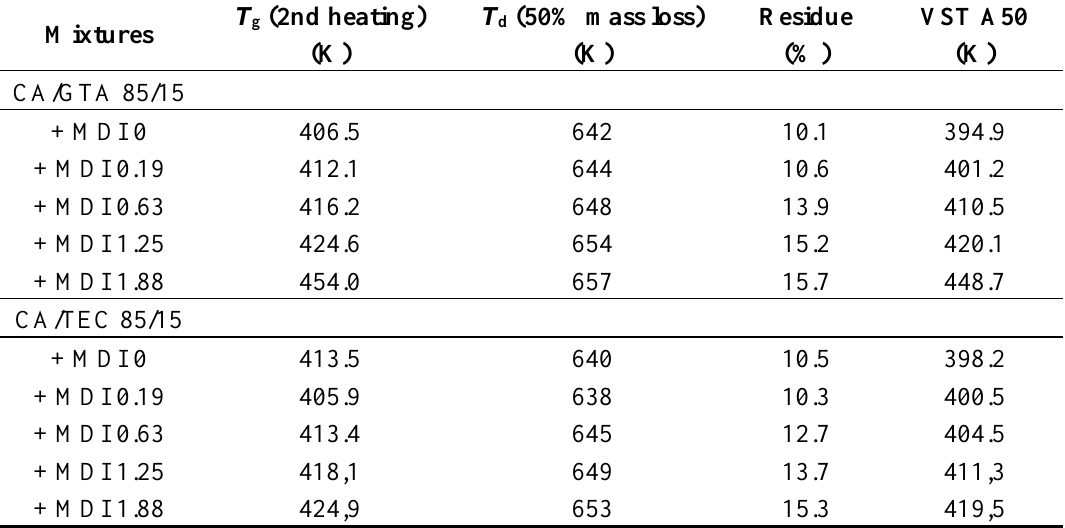
Table 5. Characteristic thermal properties of CA/GTA/MDI and